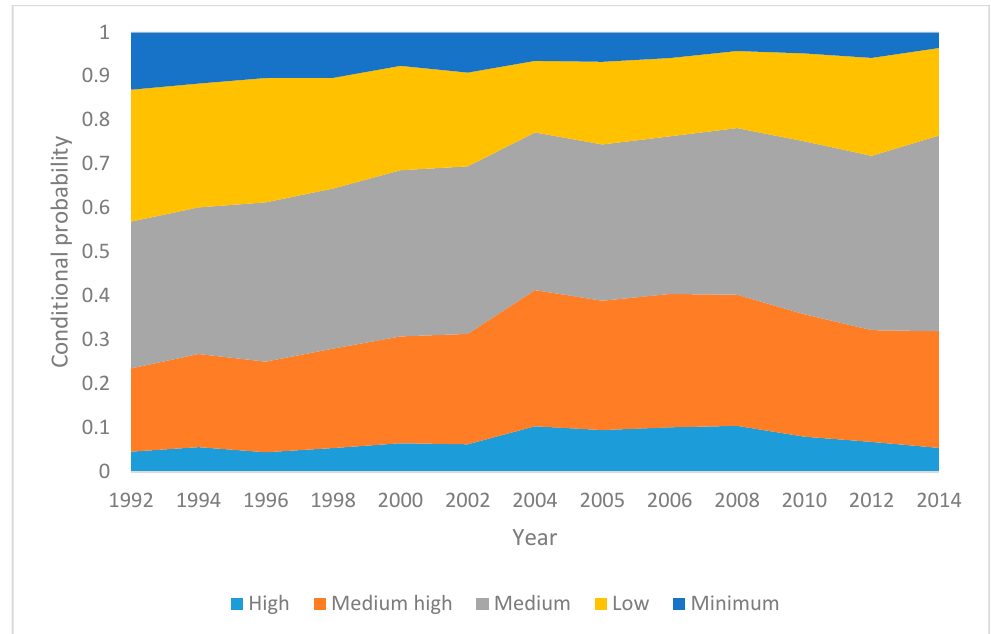
Figure 9. Conditional probabilities for consumer practices latent class membership over time. Mexico